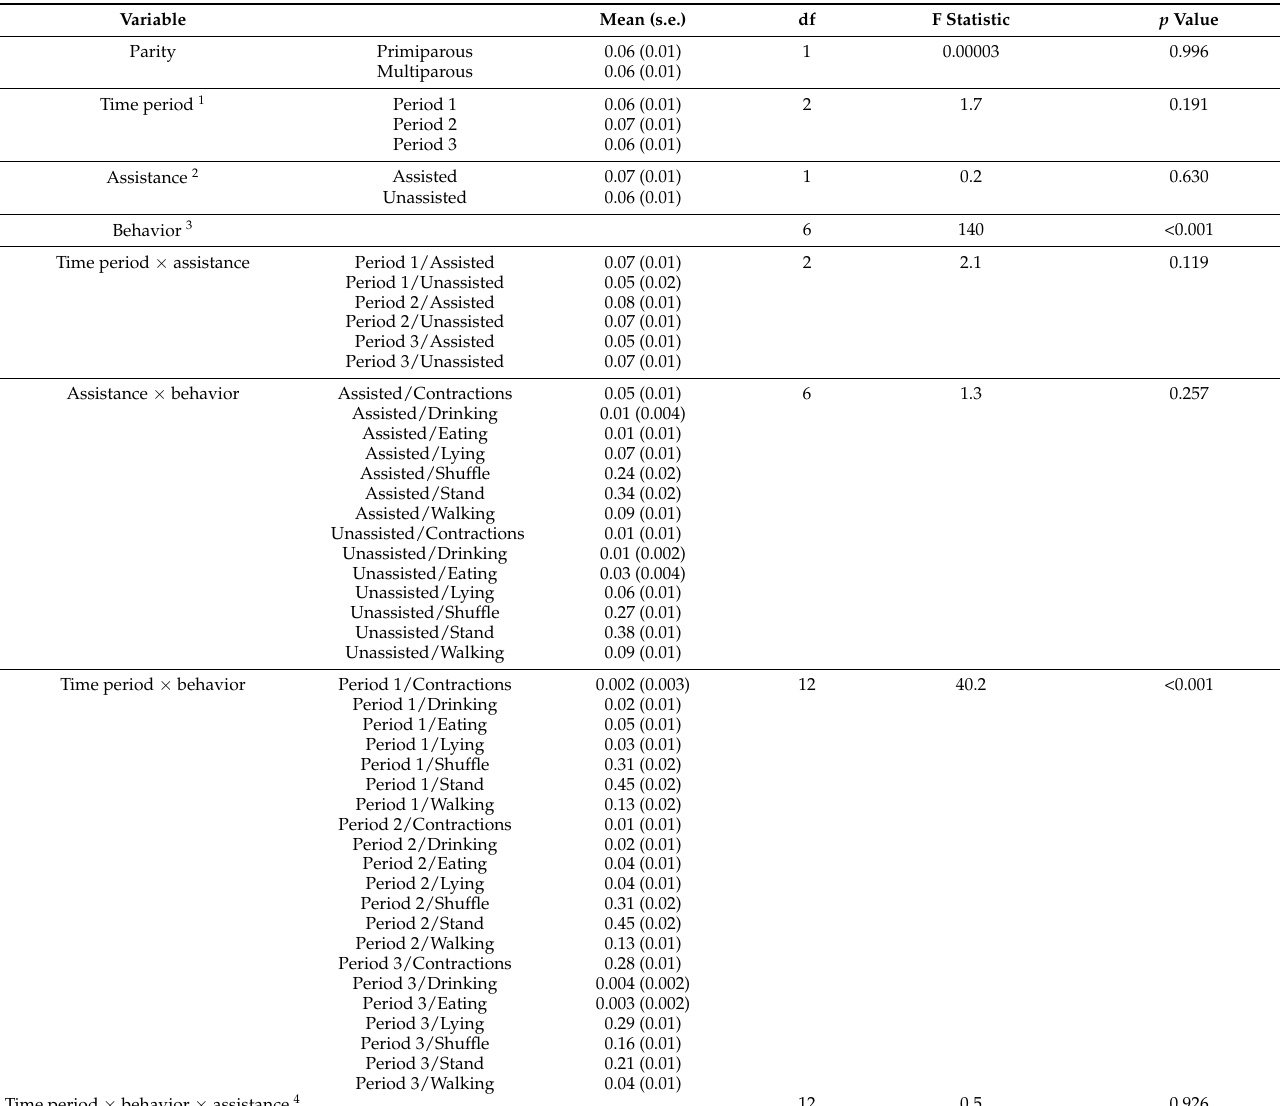
Figure 3. Predicted mean ( ± SEM) proportion of observations for different dairy cow ( n = 35) behaviors during the 9 h prior to calving. In the final three hours prior to calving, the frequency of lying and contraction bouts increased and the standing, shuffle, walking, drinking and eating bouts decreased ( p < 0.001; Table 2 and Figure 4). Table 2. Effects of parity, time period and calving assistance on the frequency of dairy cow ( n = 35) behaviors as a proportion of observations.